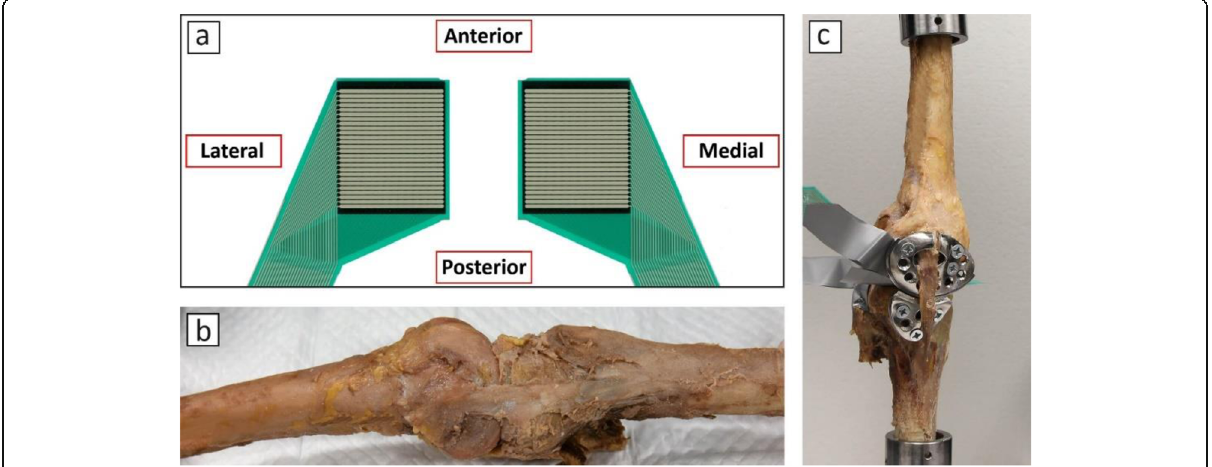
Fig. 7 a direction of the sensor in the joint during experiments, b medial view of the specimen without implant, c experimental setup with implant